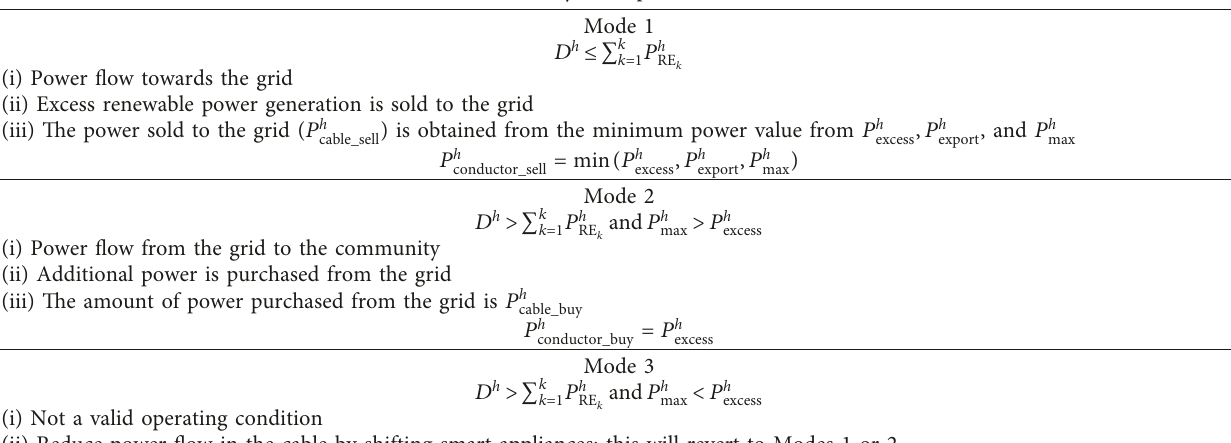
Figure 1: Smart community with grid Table 1: System operation cases.